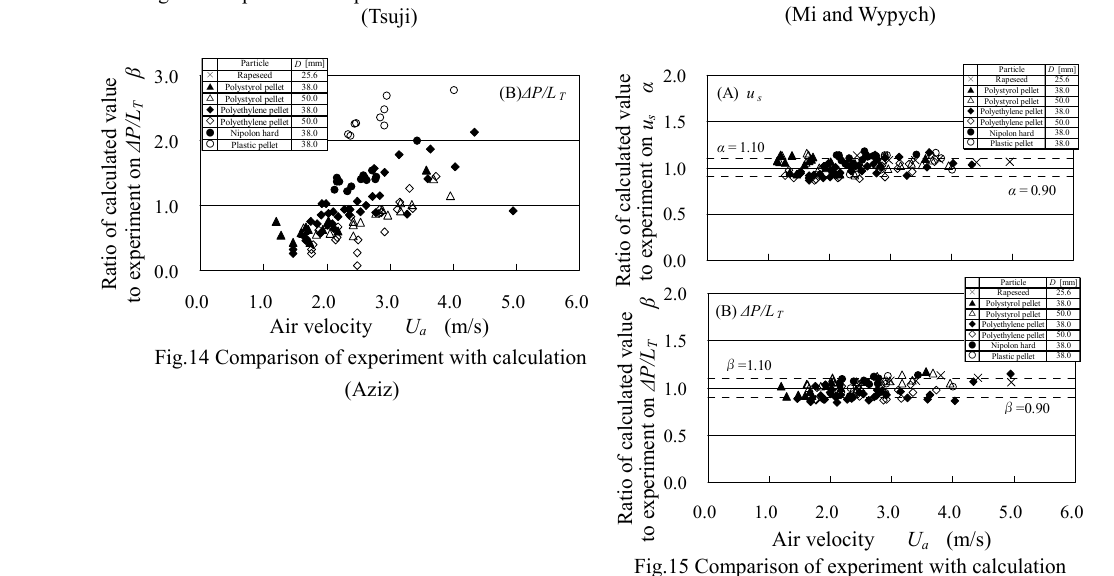
Fig.15 Comparison of experiment with